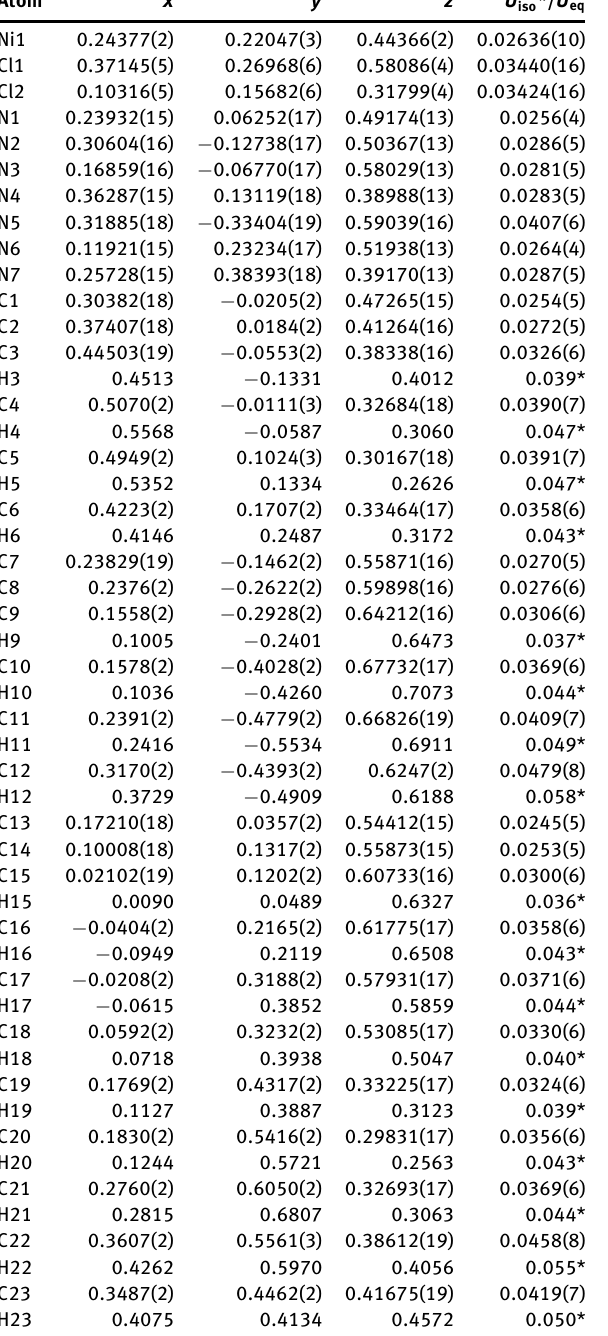
Table 2: Fractional atomic coordinates and isotropic or equivalent isotropic displacement parameters (Å 2